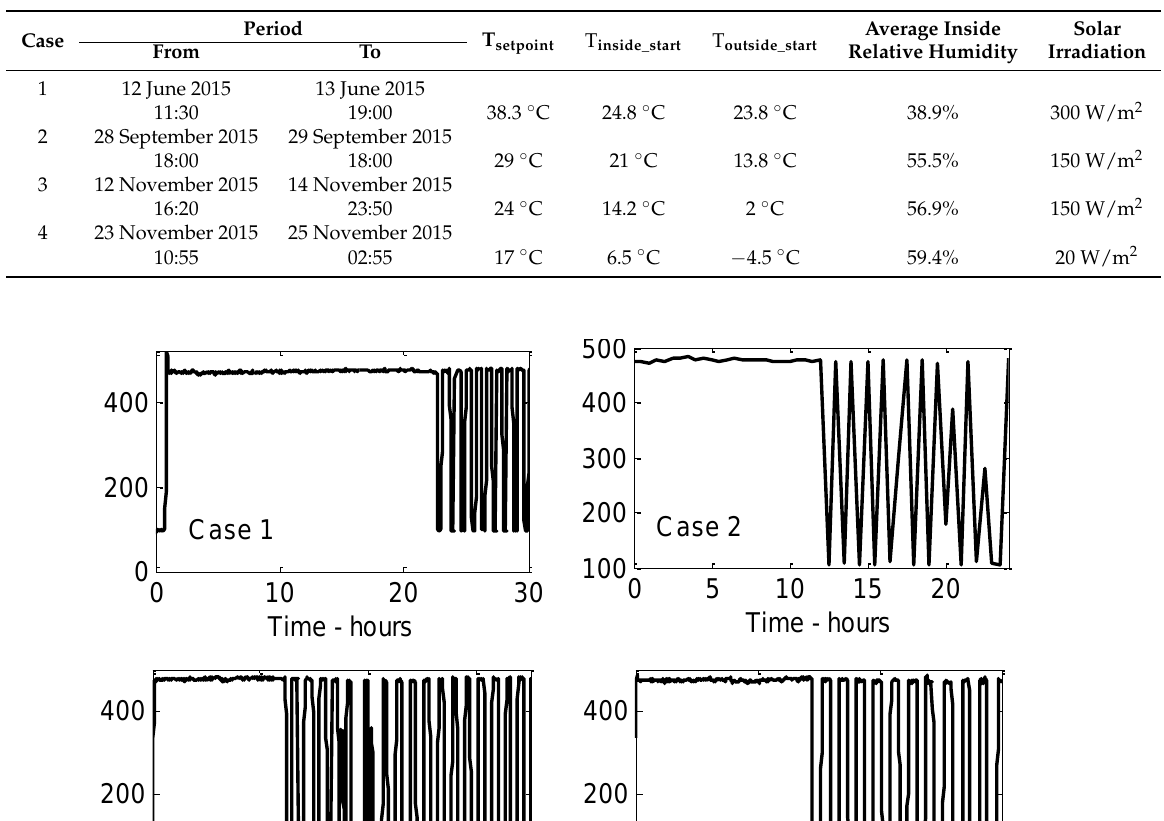
Table 3. Different cases used for predicting the heating time.